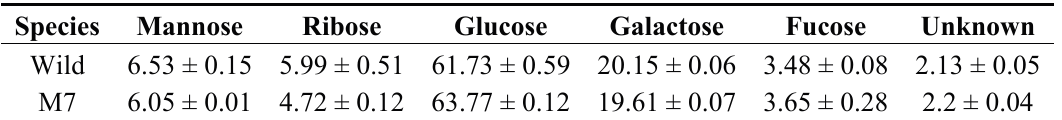
Table 2. Monosaccharide composition (in mol %) of crude EPS from the wild type and mutant M7 of C. cohnii